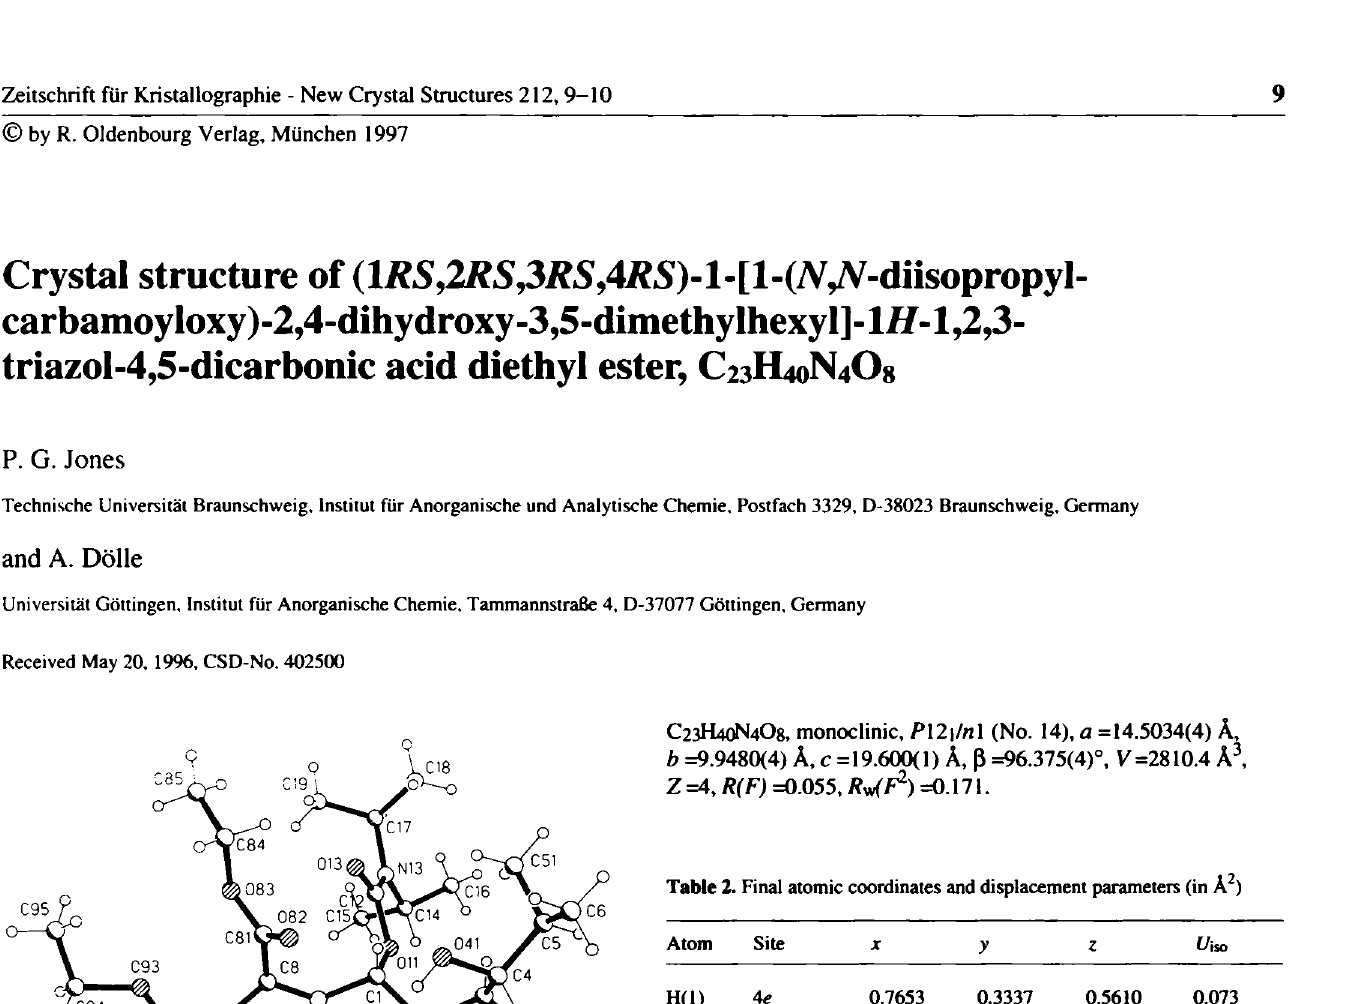
Table 2. Final atomic coordinates and displacement parameters (in Â 2